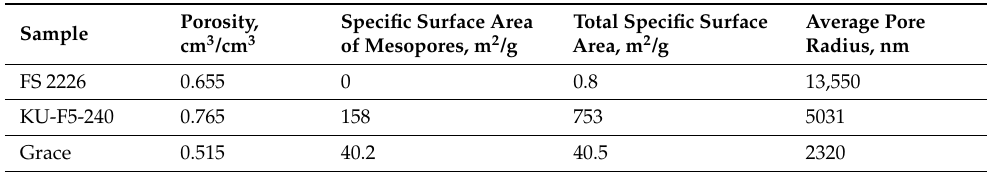
Table 1. Main characteristics of porometric measurements for FS 2226 separator, KU-F5-240 mem- brane, and Grace